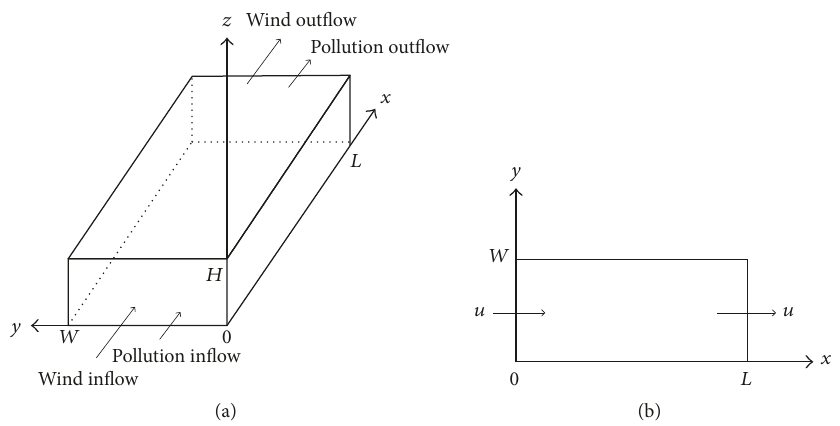
Figure 2: (a) The domain for street tunnel (Case 1). (b) The wind direction (Case 1).